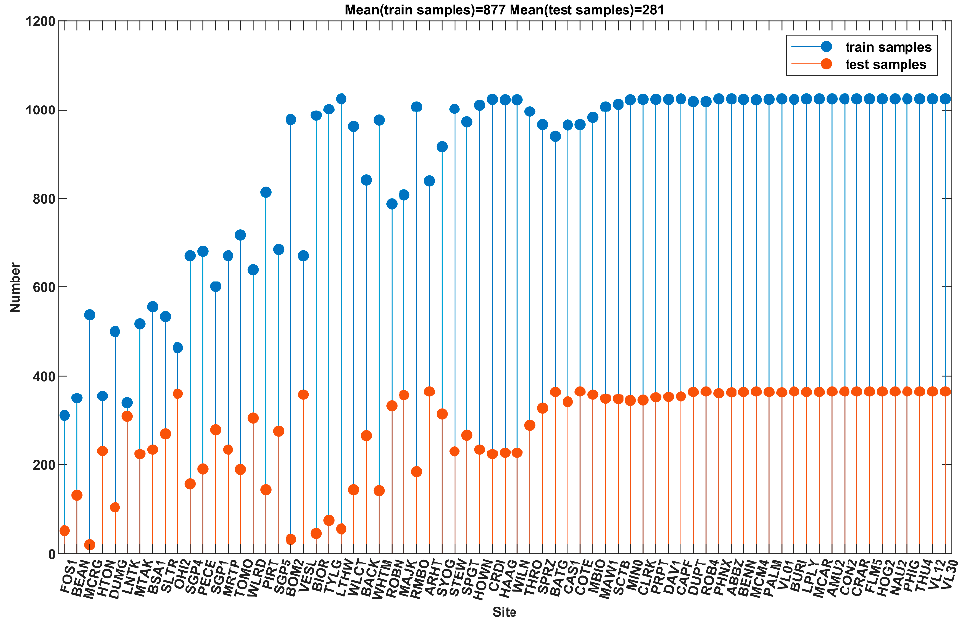
Figure 9. Statistical result of train samples and test samples of LSTM model.